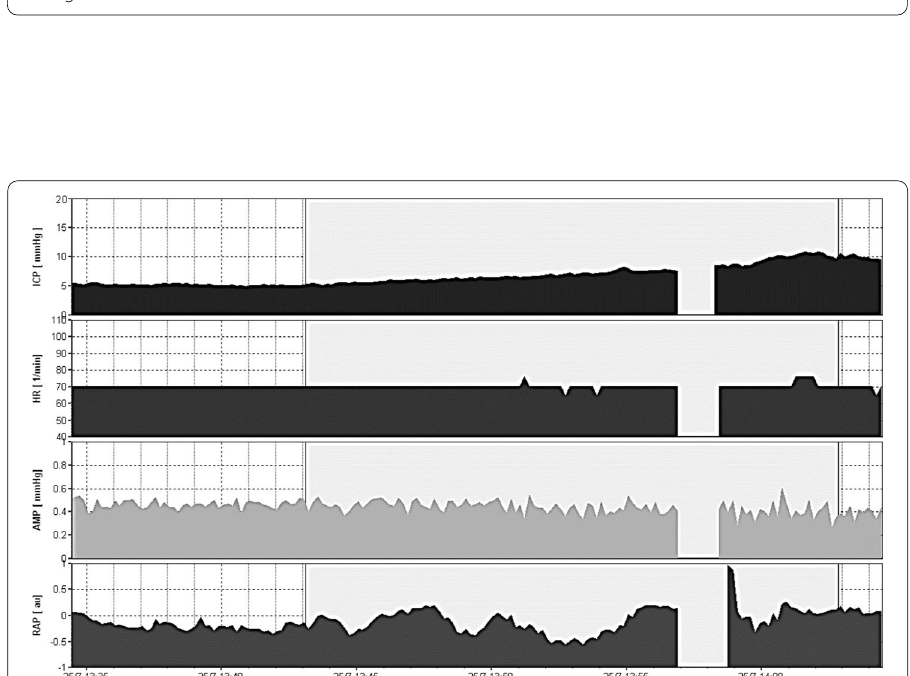
Fig. 5 Example of a constant rate infusion test in a post-SAH patient with brain atrophy. ICP during the infusion study (gray area) remains low, increasing from 5.24 mmHg to 10.36 mmHg (plateau values). There is no increase in either RAP index or AMP (amplitude), whereas there is a lack of B waves during infusion (absence of significant spikes in ICP and AMP signals). Elasticity and resistance R to CSF outflow are 0.04 ml − 1 and 3, 4 mmHg ml − 1 min − 1 , respectively. Such low values indicate brain atrophy rather than × ×